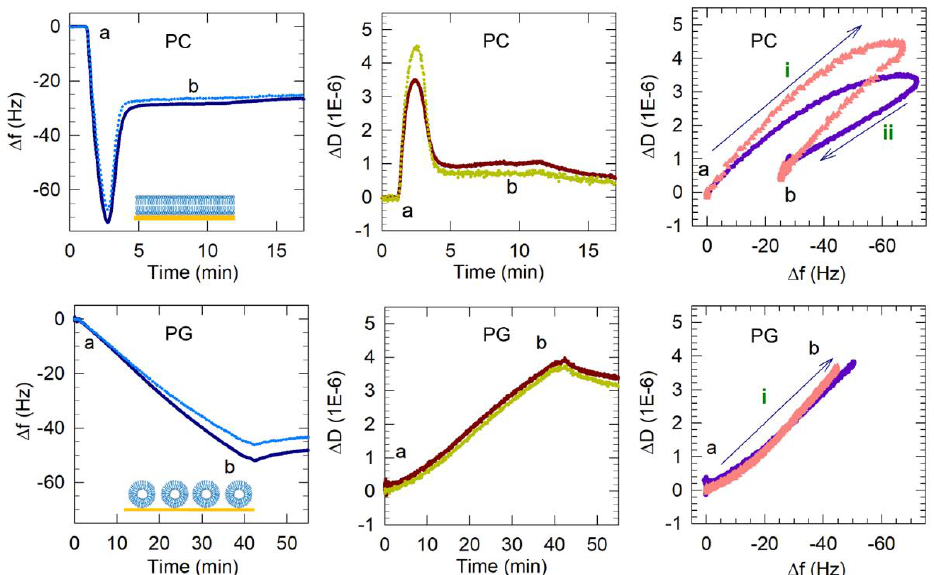
Figure 5. Representative QCM-D results showing the flow of PC vesicles over silica (non-coated) and PG and PG/LPG vesicles over APTMS-coated silica. Time points marking the start and end (a and b) of vesicle flow are represented in the frequency and dissipation shifts measured over time and also in the Δf–ΔD plots. Only the 3rd and 11th harmonics are shown for clarity. Based on these QCM-D results, the final membrane configurations (complete bilayer, incomplete bilayer or vesicle layer) are represented by the graphics in the Δf–time plots. The frequency axes in the Δf–ΔD plots are reversed so that progression of points to the right represents mass increase. The progression to the top indicates increasing viscoelasticity. The arrows (labeled i and ii) show the progression of data points over time and the sequence of different processes occurring on the sensor surface. For PG, only the process i is observed while, for PC, two processes are seen. The data shown for PC bilayer formation were adapted from previous publications from this lab [14,15]. Copyright Wang et al, Colloids Surf. B Biointerfaces, 2014; Wang et al, Biophys.Chem.,